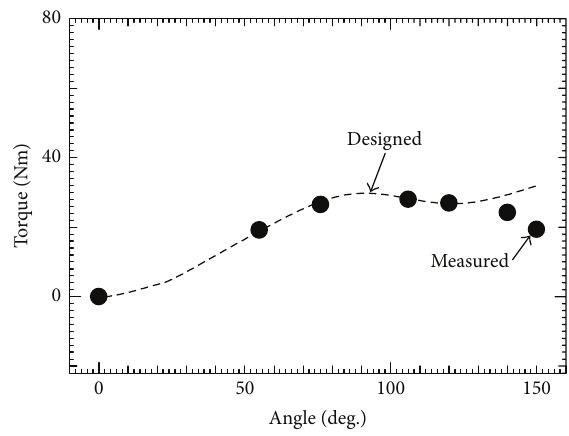
Figure 15: Comparison of the measured and design torque.